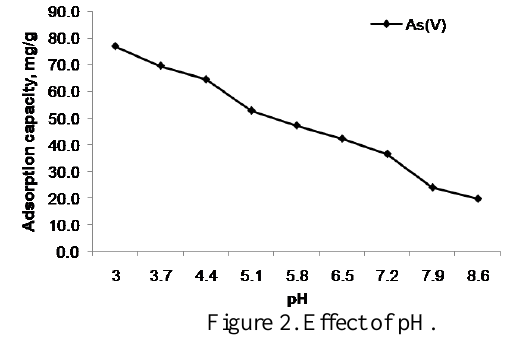
Figure 2. Effect of